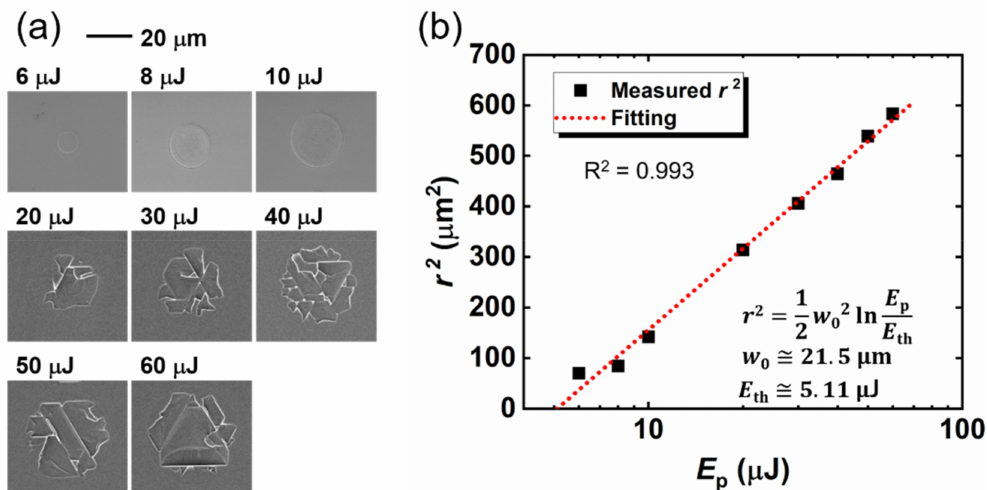
Figure 3. ( a ) SEM image of one-pulse irradiated spots. ( b ) The square of the spot radius (black squares) is plotted as a function of the pulse energy. The slope of the linear fitting yields the beam radius at the surface ( w 0 ). The extrapolation to zero shows the ablation threshold in the energy ( E th ) of one-pulse